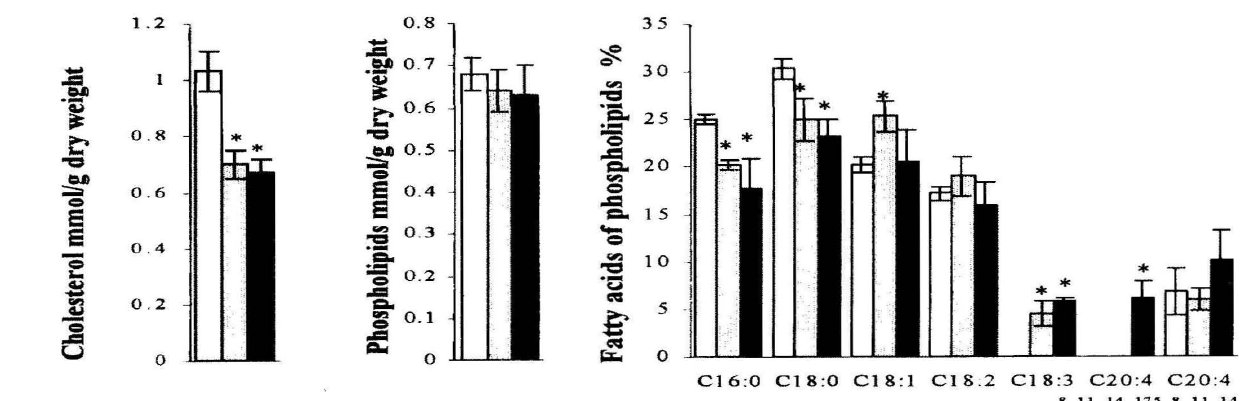
Figure 2. Concentrations (mean±S.D.) of cholesteroL and phosphoLipids, as well as fatty acid content (in percent: m ean±S.D.) in controls (open bars) and in sampLes with 5 pmoljg wet weight 7,8-dihydroneopterin (dotted bars) and 30 pmoL/g wet weight 7,8-dihydroneopterin (hatched bars). SampLes of rat liver tissue honlOgenates were used to test for phospholipid biosynthesis in vitro. Incubation medium: Krebs-Ringer-phosphate buffer, containing 0.3% albumin (pH=7.4 ), fatty acid mixture and gLyceroL Samples were incubated twice for 4 h at 37"C. *The changes are statistically significant (p<O .002